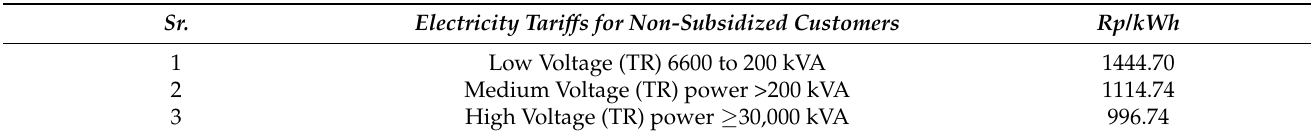
Figure 6. Yearly Photovoltaic power potential in Indonesia [35]. Table 1. The Electricity Tariffs in Indonesia